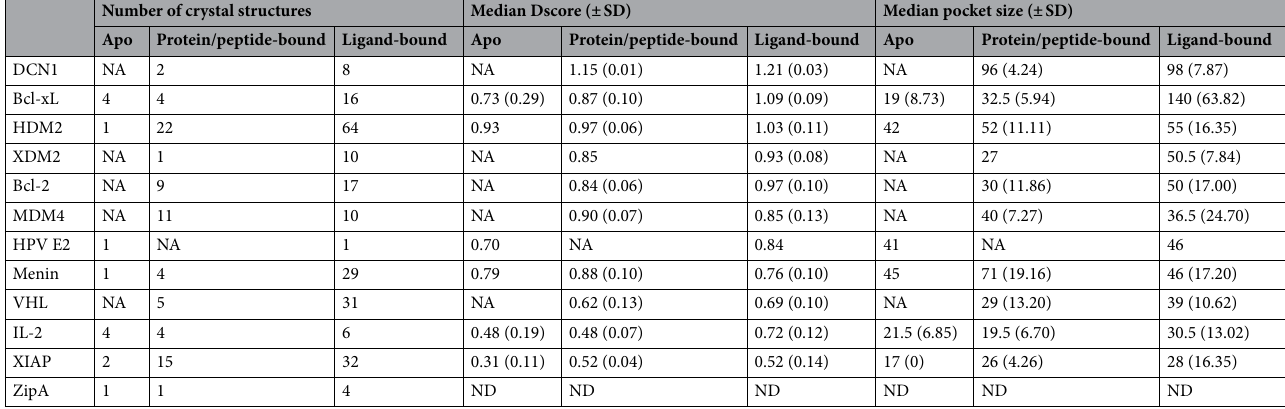
Table 3. Median druggability score (Dscore) and pocket size values for the 12 PPIs studied. ND indicates no